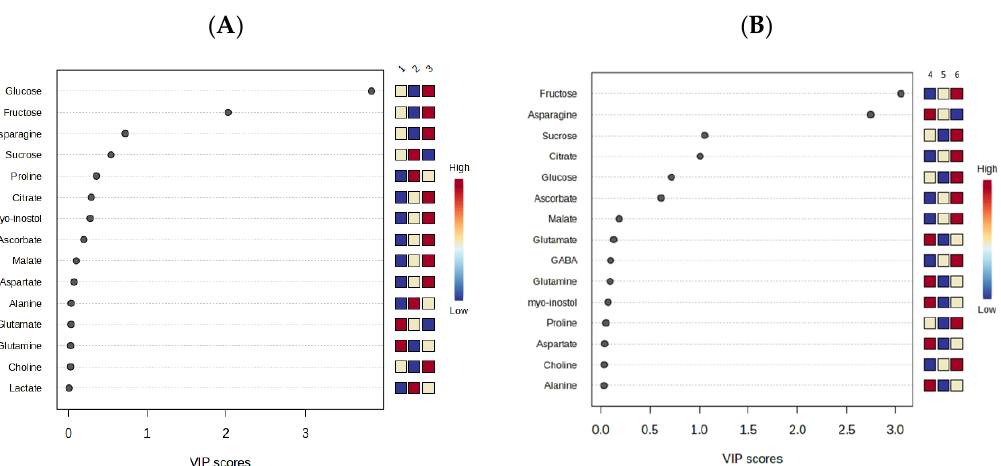
Figure 3. VIP scores (variable importance in projection) plot, derived from the partial least squares discriminant analysis (PLS-DA), is shown along with the corresponding heat map in which red and blue colors indicate the level of metabolites. The analysis is performed for ( A ) the rootstock used ( n = 3) and ( B ) the substrate used ( n = 3), where 1 to 3 corresponds to the rootstock type as (1) Citrus macrophylla ; (2) Citrus aurantium ; and (3) Citrus aurantium/Citrus sinensis ; and 4 to 6 is related to the culture (4) 75% peat + 25% port sediment; (5) 50% peat + 50% port sediment; and (6) 25% peat + 75% port sediment.